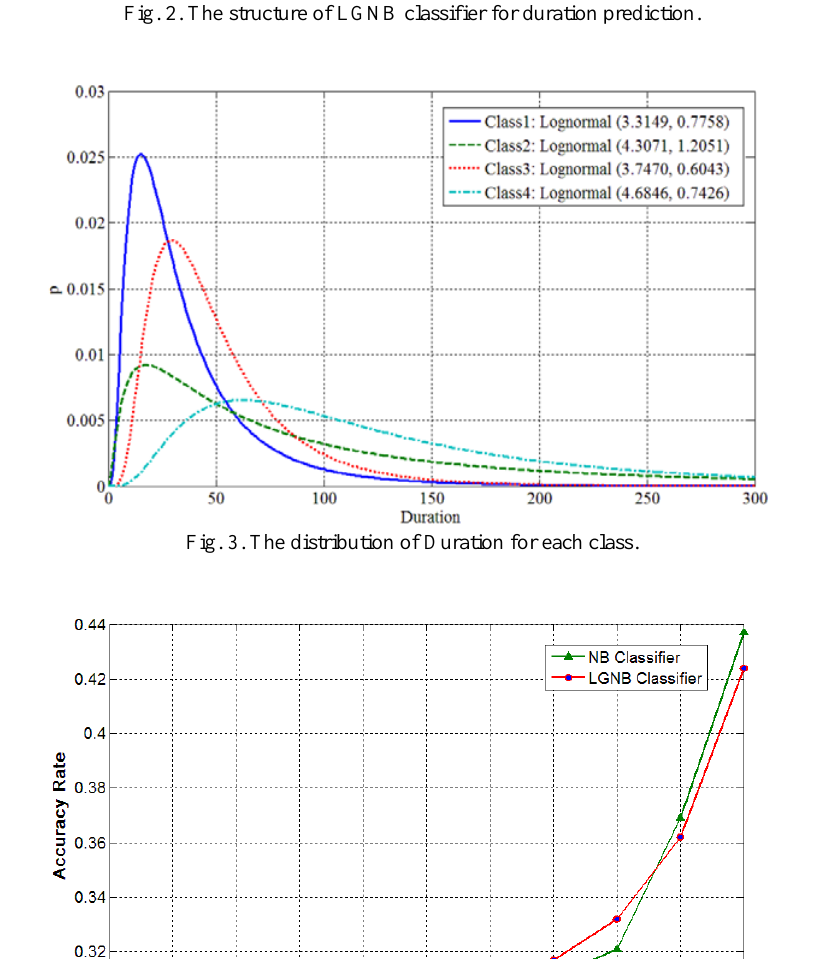
Fig. 2. The structure of LGNB classifier for duration prediction.